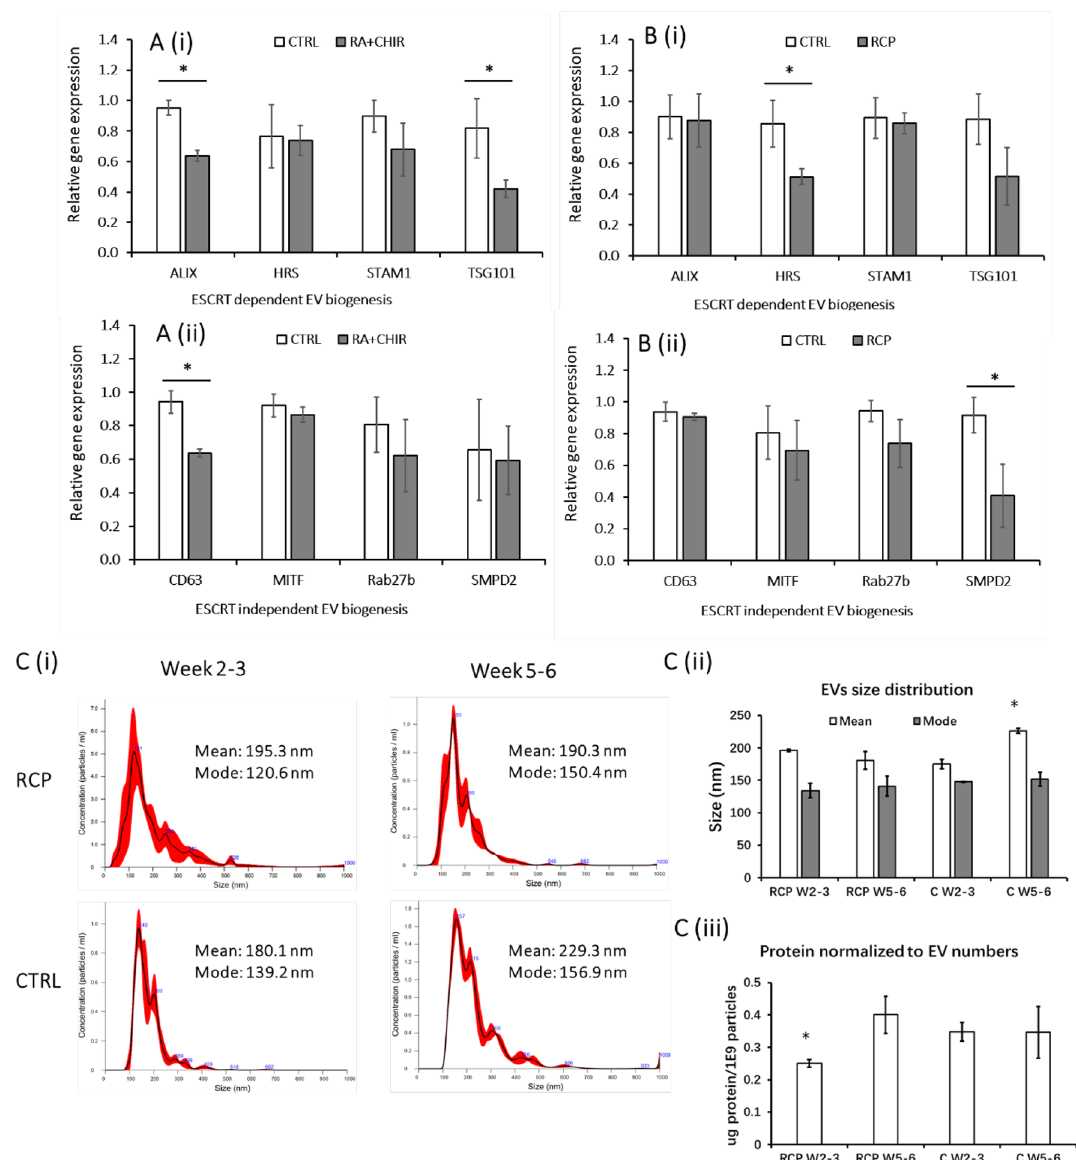
Figure 6. Extracellular vesicle (EV) biogenesis marker expression during cerebellar differentiation. The expression levels of EV biogenesis markers were determined by RT-PCR analysis. ( A ) Day 14 cells; ( B ) Day 35 cells. (i) ESCRT dependent: ALIX , HRS , STAM1 , TSG101 ; (ii) ESCRT independent: CD63. MITF , Rab27b , SMPD2 . * p < 0.05 compared to the control condition. ESCRT: the endosomal sorting complex required for transport. ( C ) (i) Extracellular vesicle (EV) size distribution determined by nanoparticle tracking analysis; EVs were isolated around day 14 (week 2–3) and around day 35 (week 5–6); (ii) Average mean and mode EV size; and (iii) protein content per 10 9 EVs. * p < 0.05 compared to other